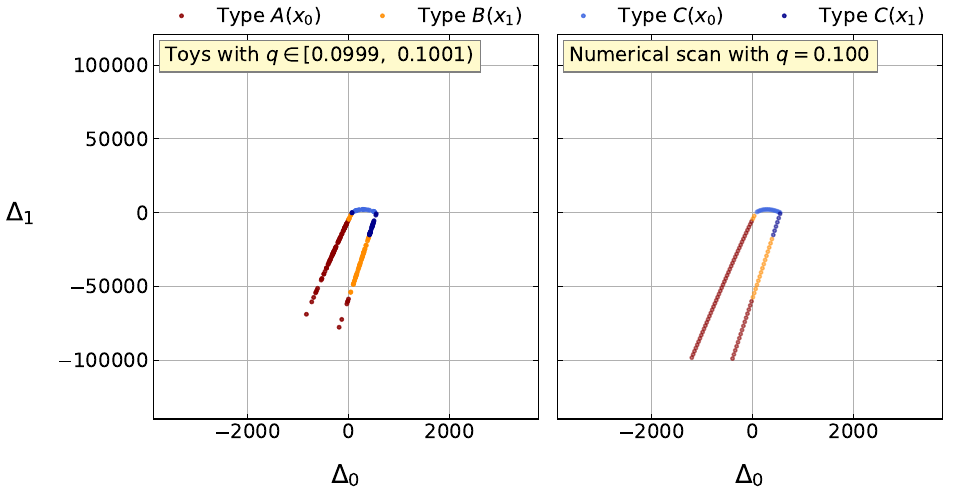
≈ 0.1. Right: c true . Good agreement is 0